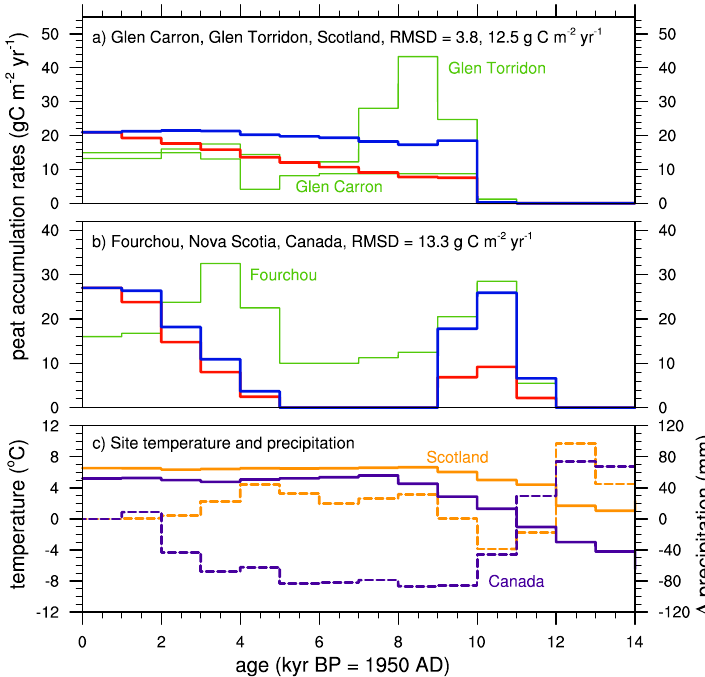
Fig. 4. Simulated gross (blue) and apparent (red) C accumulation rates for peatland sites in (a) Scotland and (b) Canada compared with reconstructed C accumulation rates (green; Yu et al., 2009; Anderson, 2002; Gorham et al., 2003). Top left values denote RMSD of simulated (red) versus reconstructed accumulation rates (green). See Appendix Fig. A1 for comparisons of simulated and reconstructed C accumulation rates from all other grid cells and sites. Panel (c) shows the annual average temperature (solid lines) and changes in annual precipitation relative to present (dashed lines) for the corresponding grid cell in Scotland (orange) and Canada (purple) in the HadCM3 model (Singarayer and Valdes,